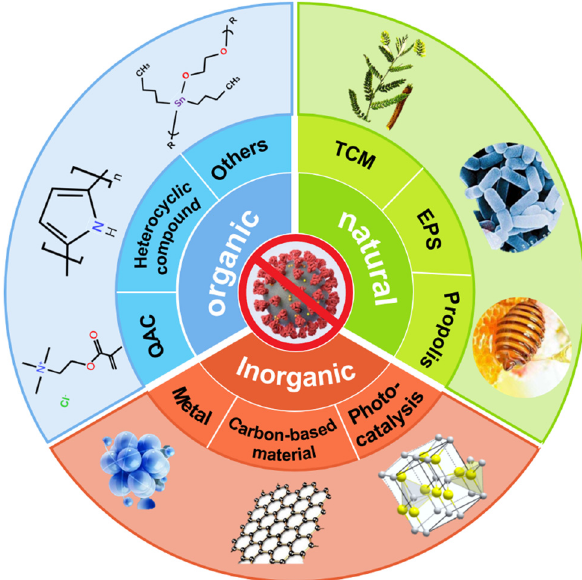
Figure 2: Classi fi cation of antiviral materials. TCM: traditional Chinese medicine; EPS: extracellular polysaccharides; QAC: quaternary ammonium